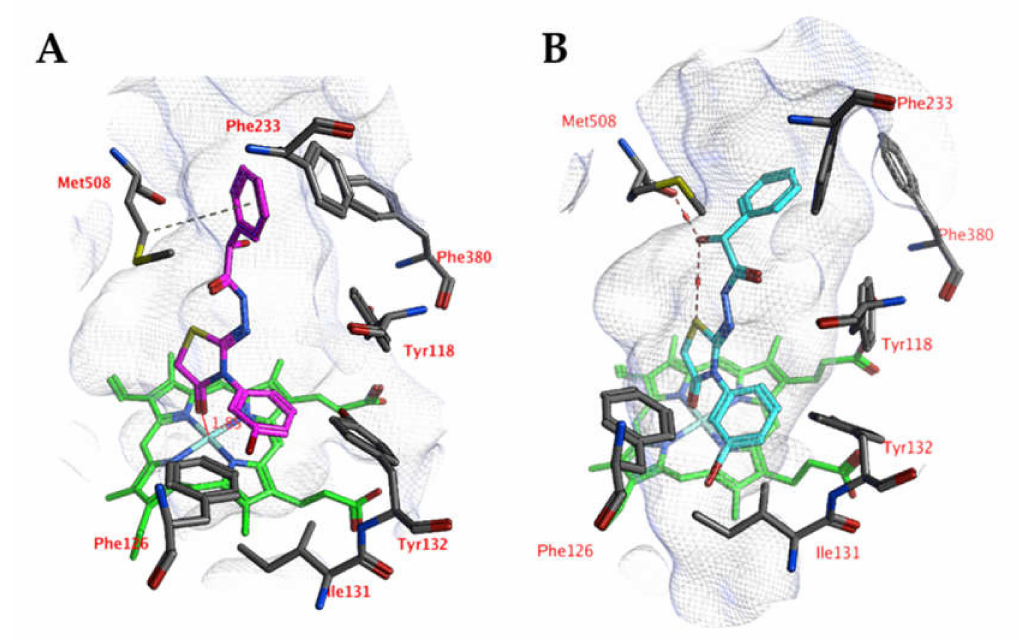
Figure 4. ( A ) The docked pose of compound 4h (turquoise) in the active site of CaCYP51 (PDB: 5v5z). ( B ) The docked pose of compound 4h (purple) after a 5-ns molecular dynamics simulation. The haem group is indicated in green sticks. The pocket surface is indicated with a white mesh. hydrogen bonds are indicated in red dashed lines.